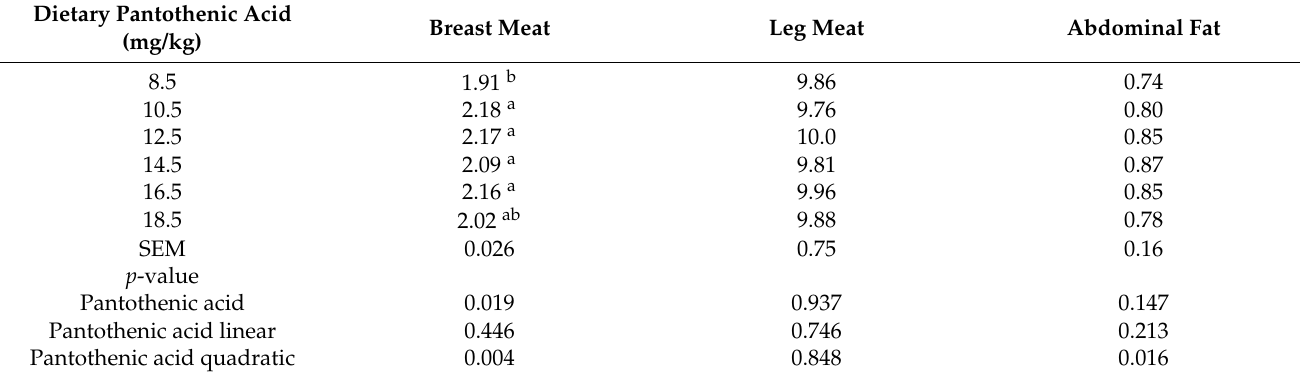
Table 4. Effect of dietary pantothenic acid levels on carcass traits of the 21-day-old male white Pekin ducks 1,2 . Dietary Pantothenic